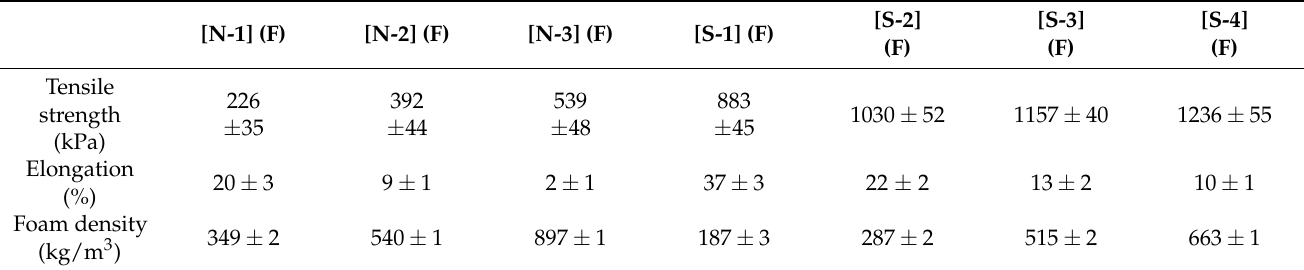
Table 2. The mechanical properties of the (SA/TPS)/PBAT composites